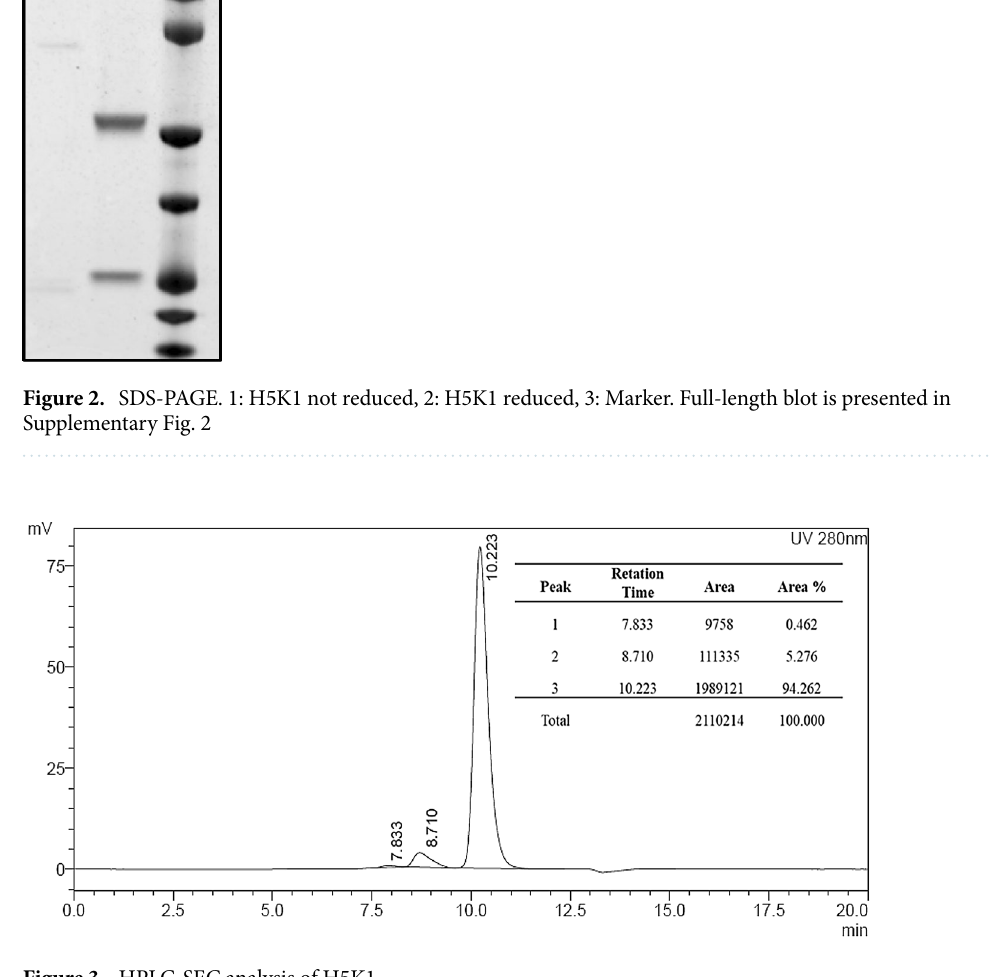
Figure 3. HPLC-SEC analysis of